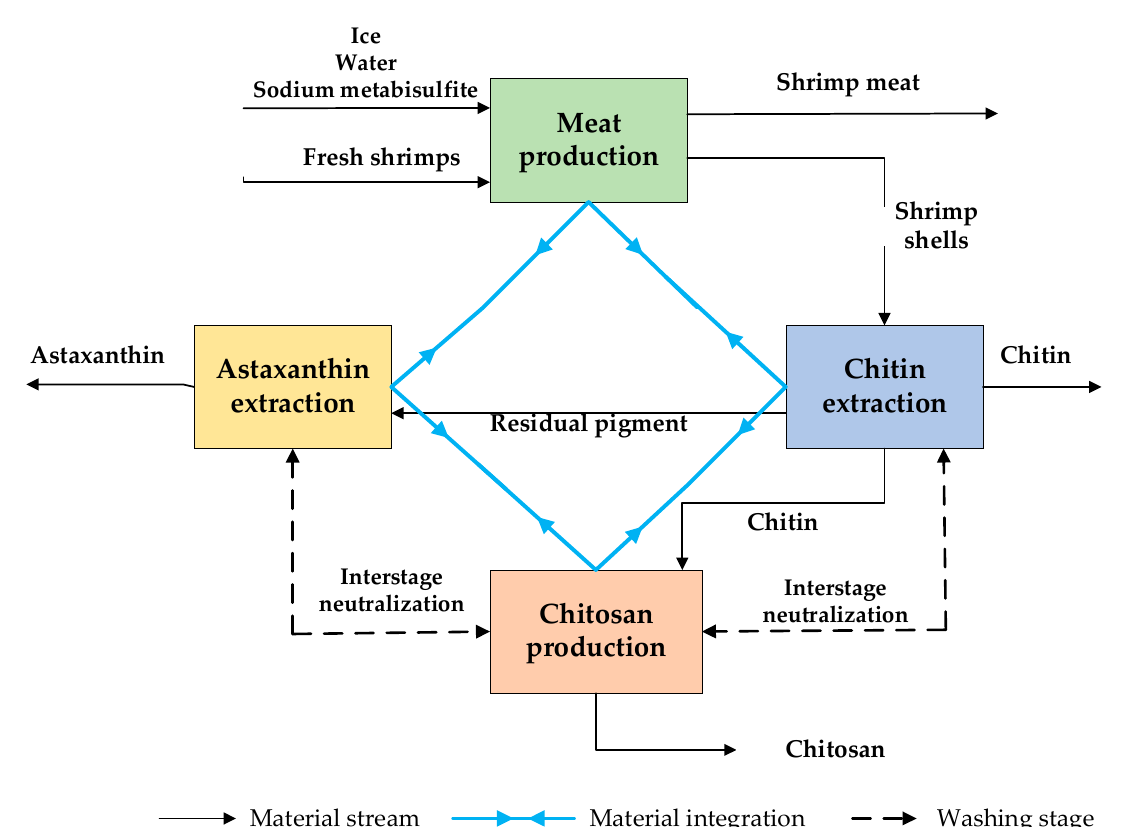
Figure 1. Process diagram of a mass integrated biorefinery based on shrimp.